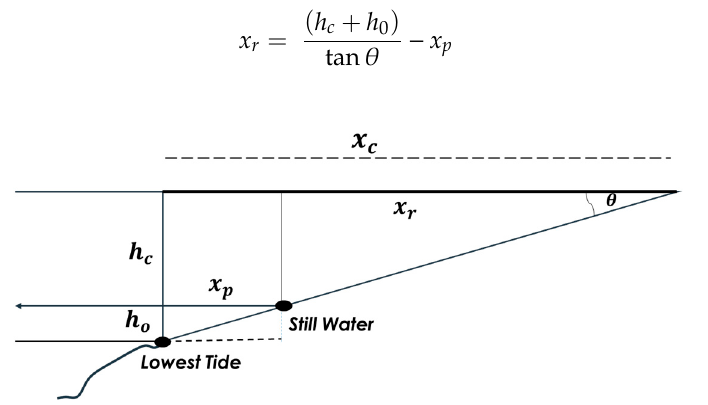
Figure 3. Scheme illustration of the tidal wave landward inundation.